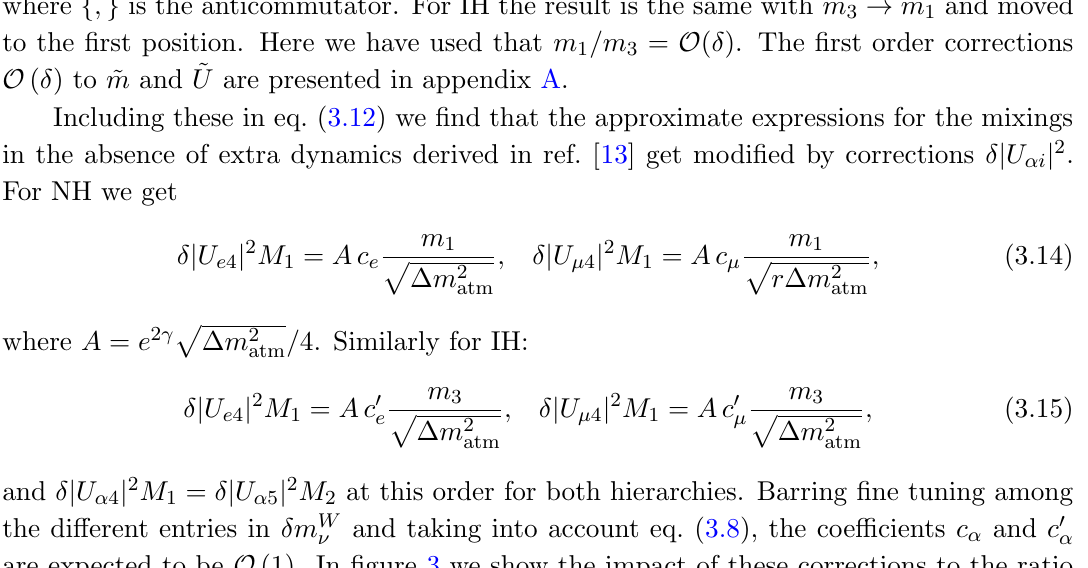
Figure 2 . Ternary diagram for the normalized (cid:13)avour mixings regime) (cid:12)xing the known oscillation parameters to their best (cid:12)t values and varying the CP phases from [0 ; 2 (cid:25) ] for NH (red) and IH